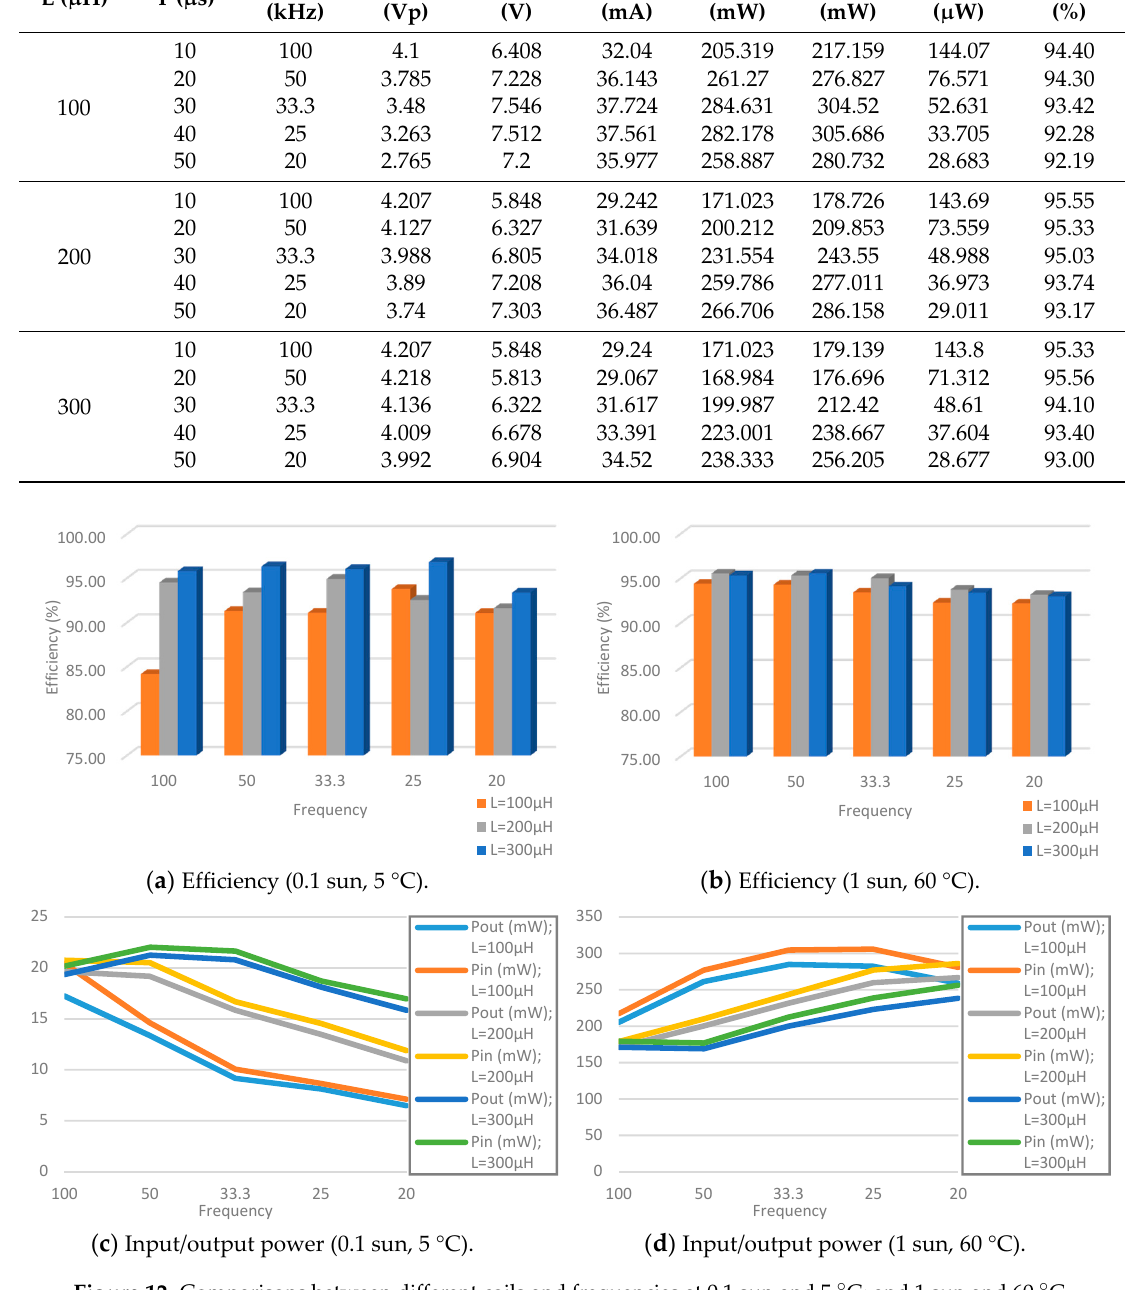
Figure 12. Comparisons between different coils and frequencies at 0.1 sun and 5 °C; and 1 sun and 60 °C.